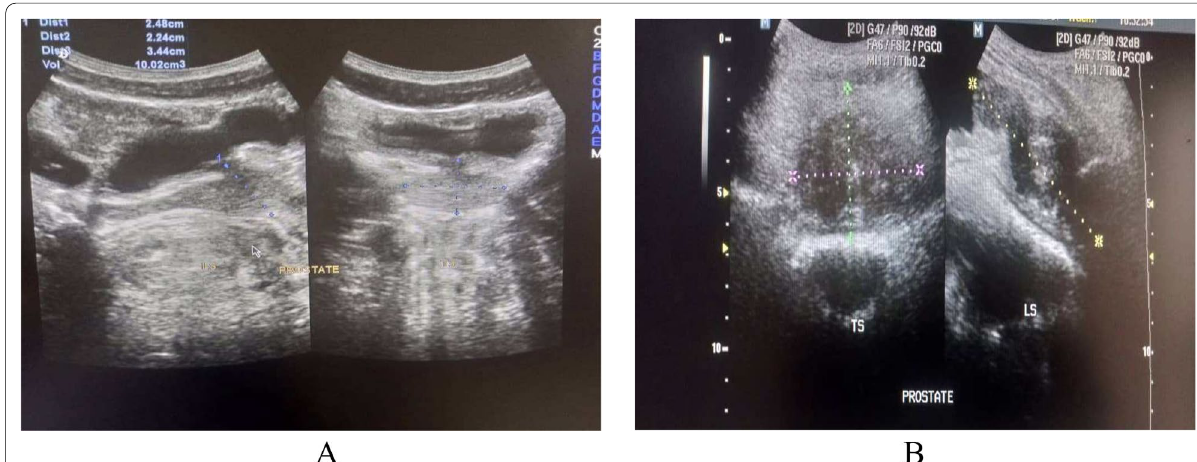
Fig. 1 The ultrasonography of the prostate in the control ( A ) and test ( B )